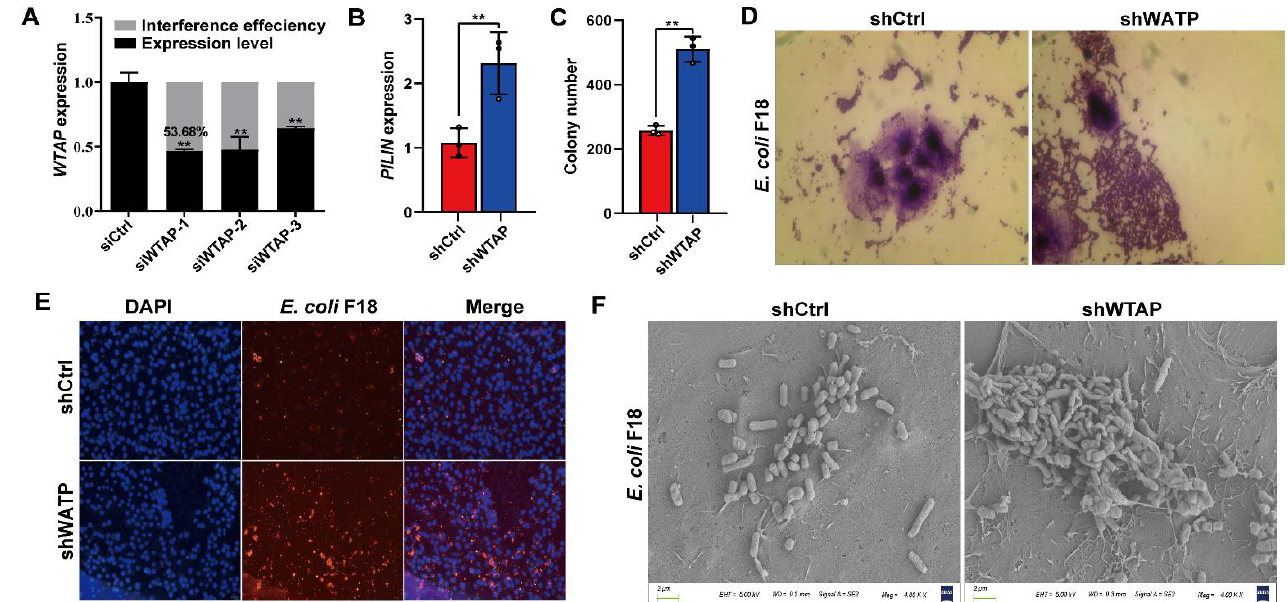
Figure 2. WTAP is required for affecting E. coli F18 adhesion in IPEC-J2 cells. ( A ) Knockdown efficiency of WTAP gene in IPEC-J2 cells was determined using qRT-PCR. ( B ) Expression detection of E. coi F18 fimbriae gene ( PILIN ) via relative quantification in WTAP -silenced IPEC-J2 cells. ( C ) Colony number of E. coi F18 fimbria adhering to IPEC-J2 cells were evaluated in treatment group. ( D ) Gram staining assay, an optical microscope (400×, scale bar = 100 μm ) was used to observe the IPEC-J2 cells. ( E ) Indirect immunofluorescence assay, blue fluorescence indicates nuclear staining via DAPI; red fluorescence indicates staining with the anti- E. coli antibody. Cells were observed under a fluorescence microscope (100×, scale bar = 1 mm). ( F ) Scanning electron microscopy (SEM) assay, cells were observed under a scanning electron microscope (2000×). All data are presented as the mean ± SD, ** p < 0.01.